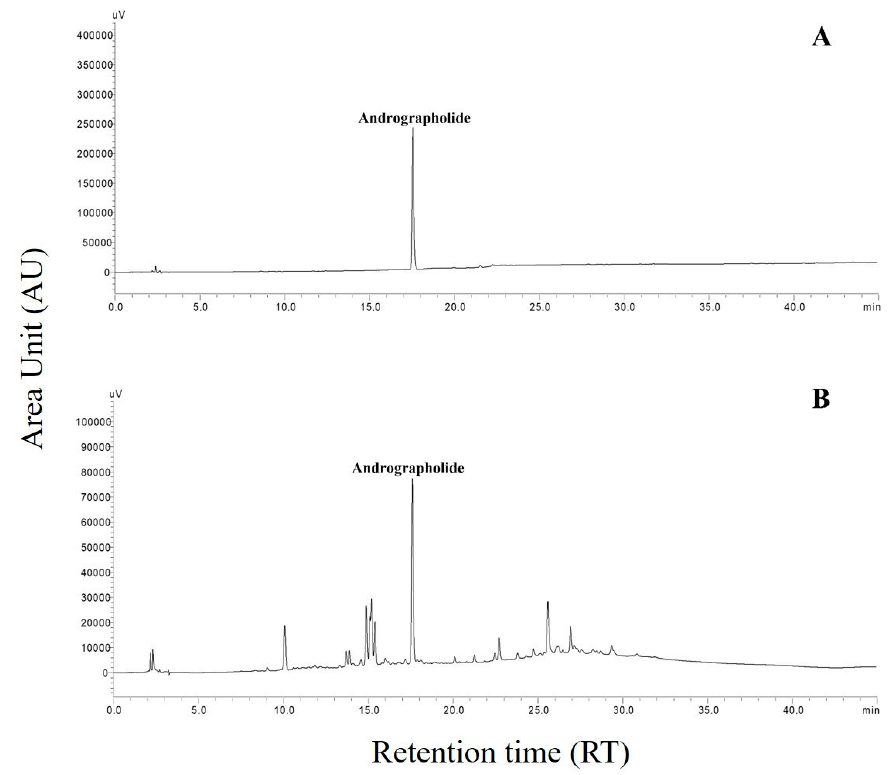
Figure 1. HPLC chromatogram of andrographolide ( A ) and Andrographis paniculata ( B ).